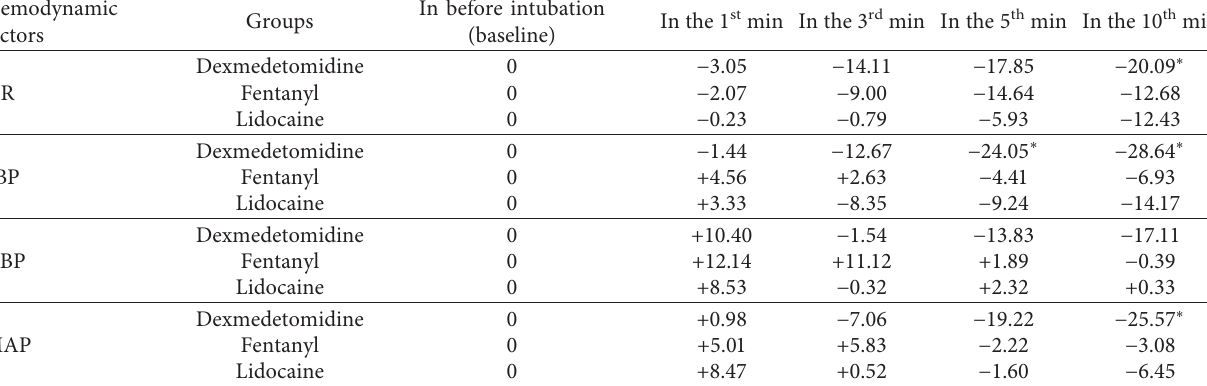
Table 6: The rate of change in the effectiveness of dexmedetomidine, fentanyl, and lidocaine compared to baseline values in each of the four hemodynamic indexes (HR, SBP, DBP, and MAP).